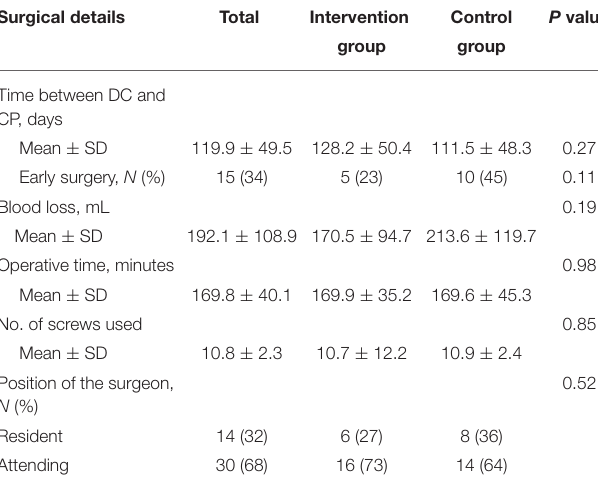
TABLE 2 | Surgical details of patients.